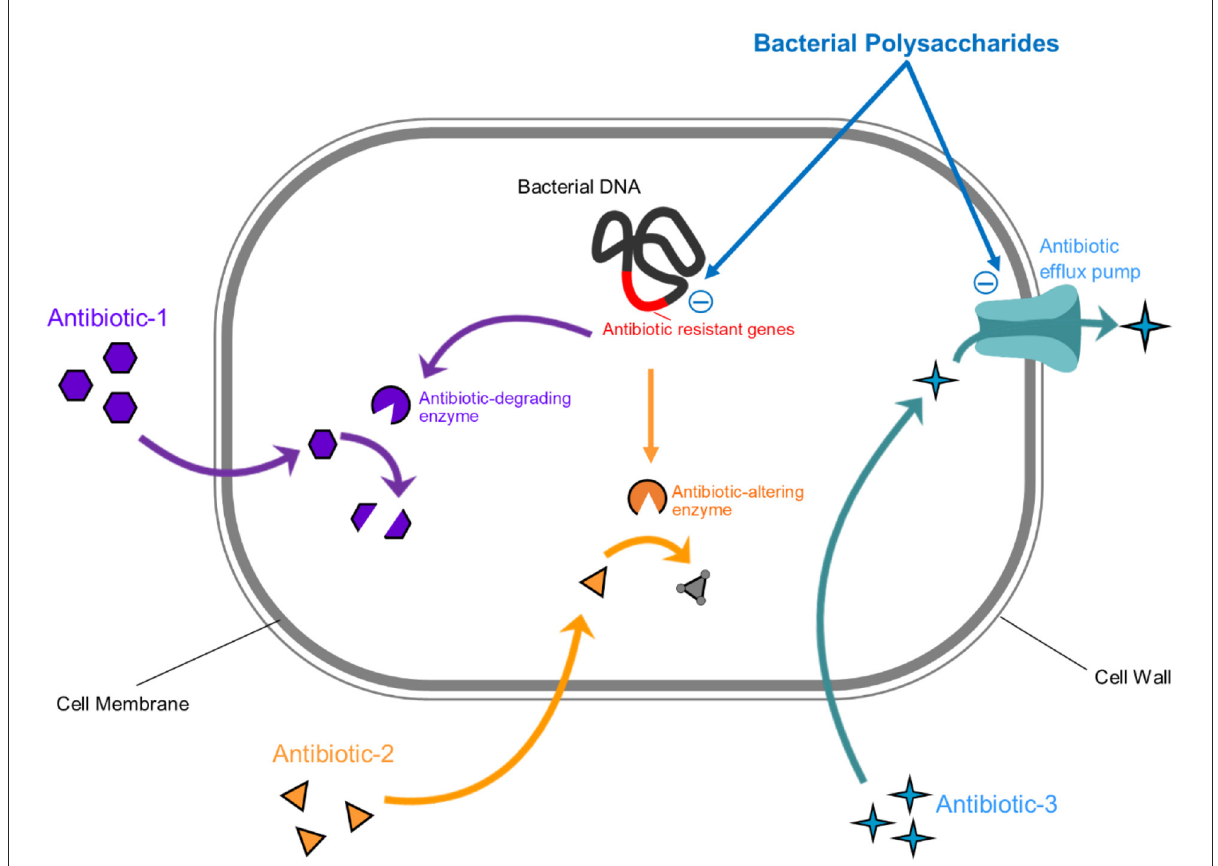
FIGURE4 Graphical illustration of the antibacterial properties of bacterial-derived polysaccharides. Bacterial EPSs inhibit bacterial pathogens by (1) inhibiting efflux pump (which is responsible for removal of antimicrobial agent) and (2) inhibiting the expression of antimicrobial resistant